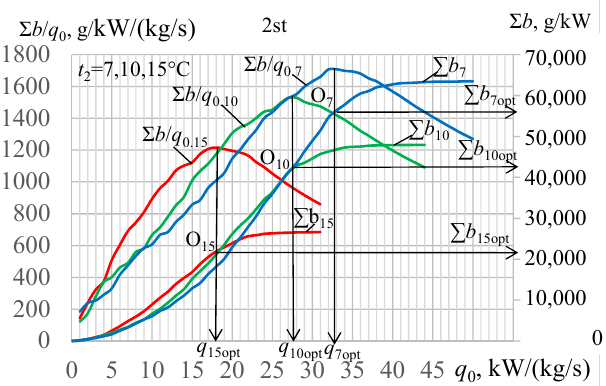
Figure 10. Annual specific fuel reduction ∑ b and relative increment of annual specific fuel reduction ( ∑ b − ∑ b opt )/ q 0 for t a2 = 15 °C ( a ) and 10 °C ( b ):· − ( ∑ b − ∑ b opt )/ q 0 .